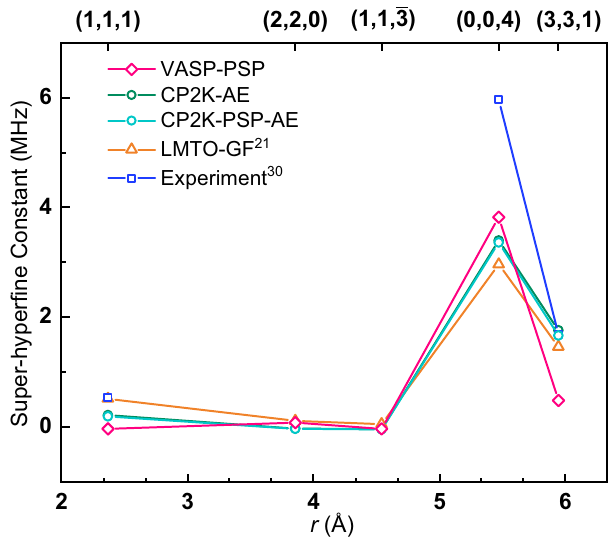
Fig. 3 Isotropic super-hyper fi ne parameters. The super-hyper fi ne constants for different shells calculated from different approaches as a function of distance to the donor center, including: Pseudopotential approximation approach (VASP-PSP), all-electron approach (CP2K-AE), Pseudopotential approximation and all-electron mixed approach (CP2K- PSP-AE), Green ’ s function approach (LMTO-GF) 21 , and experimental values 32